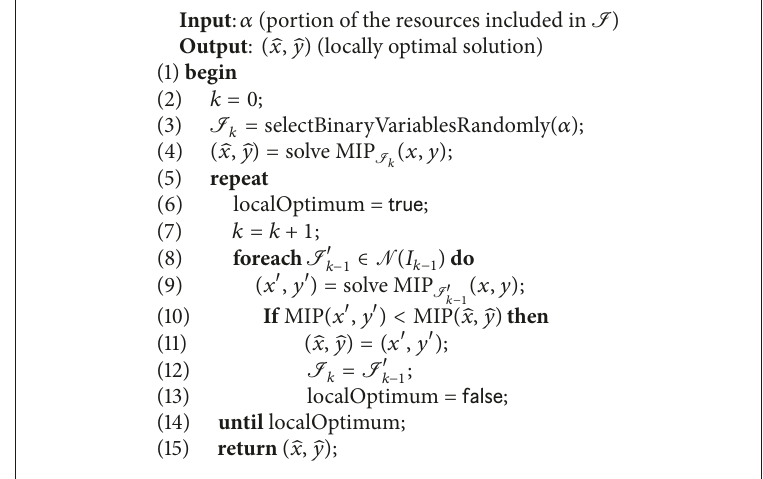
Algorithm 1: Steepest descent